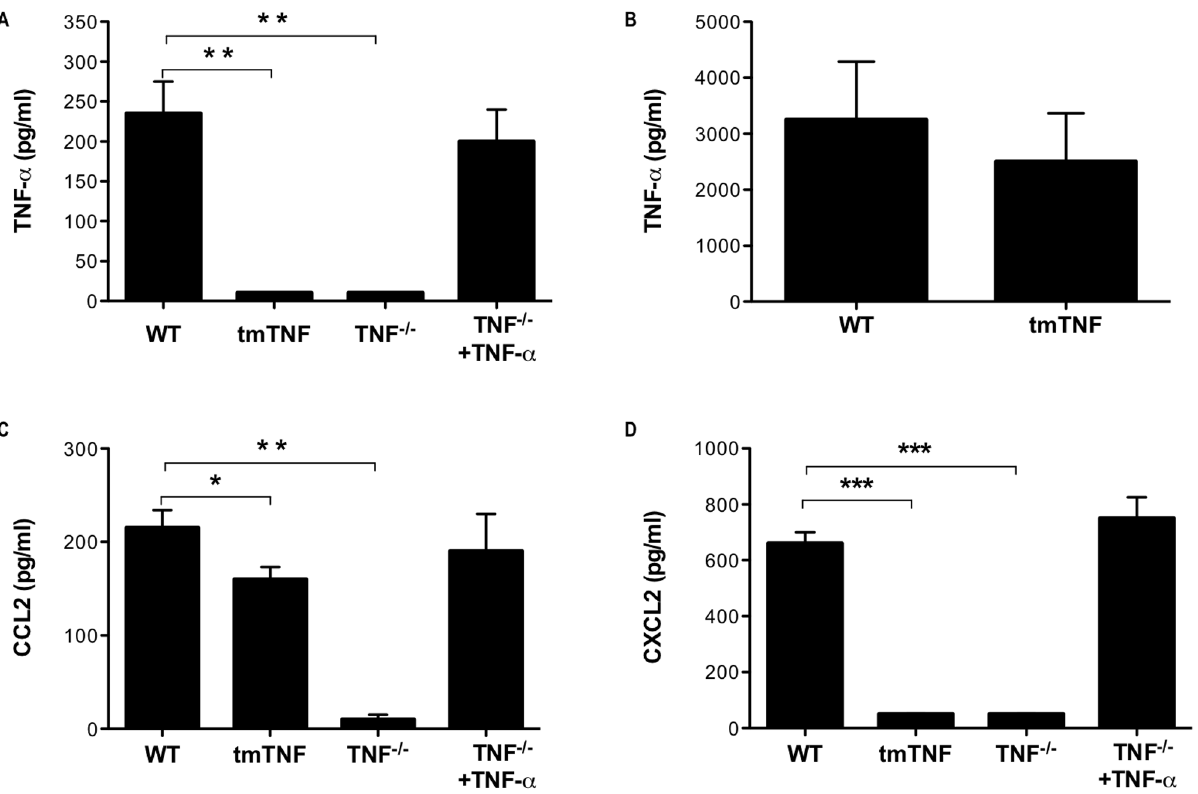
Figure 1. CD8 + T-cell processing of TNF- a is required for lung epithelial cell expression of CXCL2. MLE-K d cells were pulsed with HA 210 2 219 peptide and co-cultured with HA-specific CD8 + T cells for 5 hours. In some experiments, recombinant mouse TNF- a was added to the culture supernatant. Cell-free supernatant was analyzed for expression of (A) TNF- a , (C) CCL2, and (D) CXCL2 by ELISA. (B) Alternatively, total TNF- a production by HA-specific CD8 + T cells after PMA/ionomycin stimulation with protease inhibitor and detergent solubilization was measured by ELISA. Data represents mean 6 standard deviation. Data are representative of three independent experiments with each condition conducted in triplicate. * P , 0.05, ** P , 0.01, *** P , 0.001.